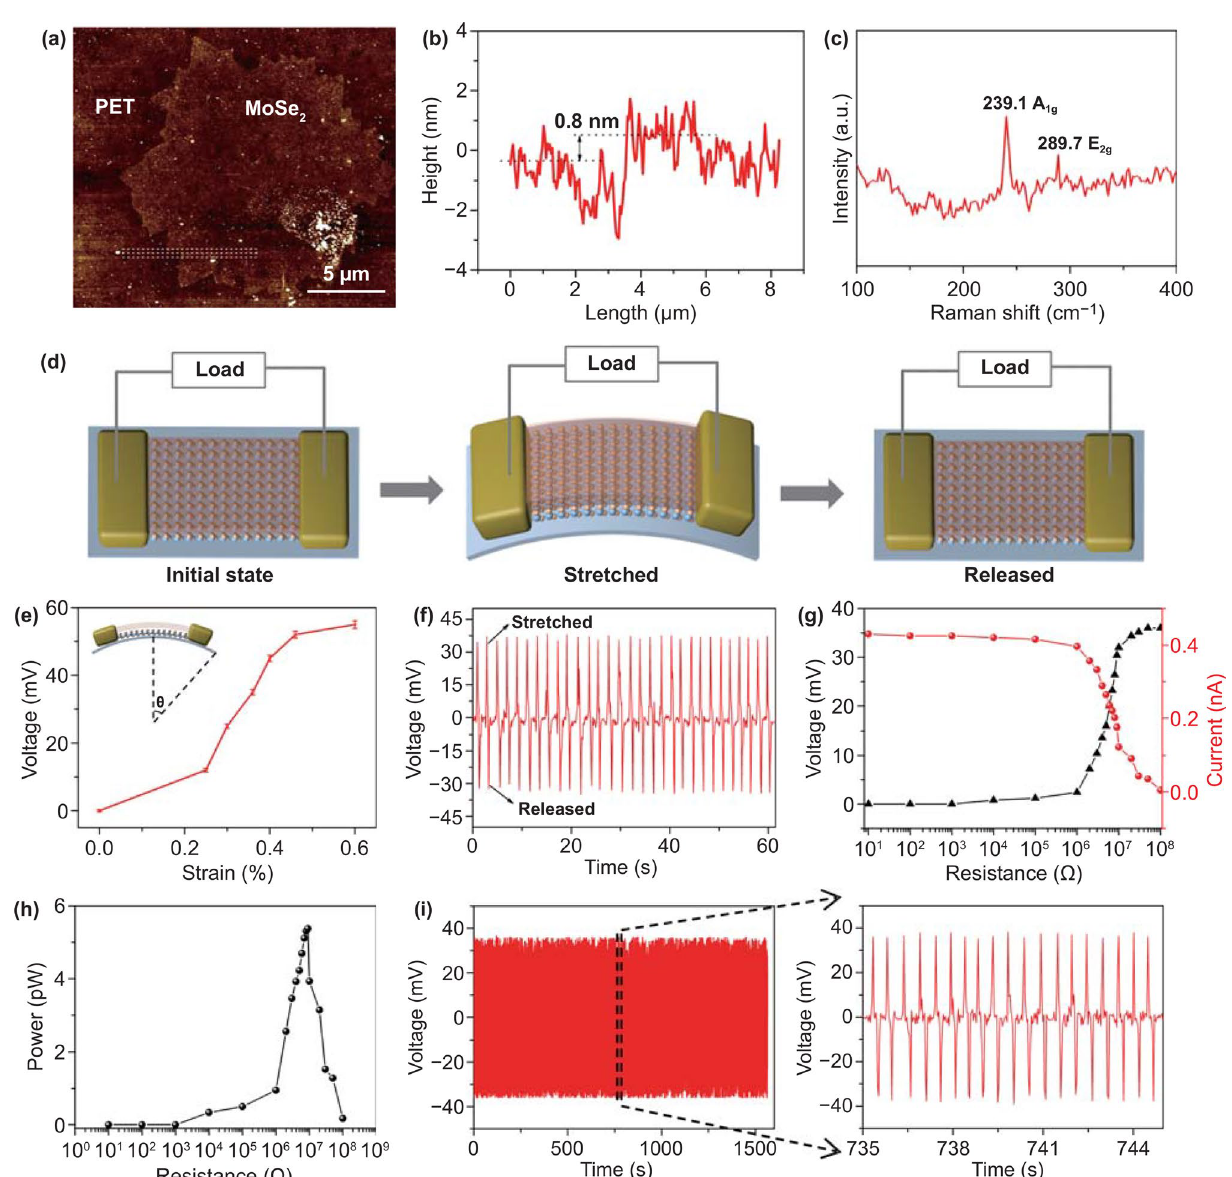
Fig. 2 a AFM topographic image of the single-layer MoSe 2 flake. b Relative heights along the white lines in Fig. 2a. c Raman spectrum of the monolayer MoSe 2 flake. d Operation scheme of the monolayer MoSe 2 piezoelectric device. e Open-circuit voltages of the device as a function of strain. f Real-time output voltage under 0.36% strain at a frequency of 0.5 Hz. g Dependence of output voltage and current from a monolayer MoSe 2 device under 0.36% strain as a function of external loading resistance. h Power versus the loading resistance. i Cyclic test showing the stability of monolayer MoSe 2 device for prolonged